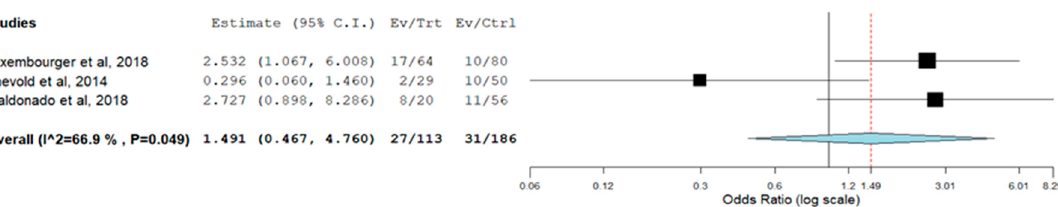
Figure 2. Forest plot of IL-6R rs 12083537 (genotype AA as control vs. genotype GG as testing/risk genotype) and response to TCZ treatment [22,23] (Ev/Trt refers to number of participants not responding to the treatment in the cohort of GG genotype carrier. Ev/Ctrl refers to number of participants not responding to the treatment in the cohort of AA genotype carrier).